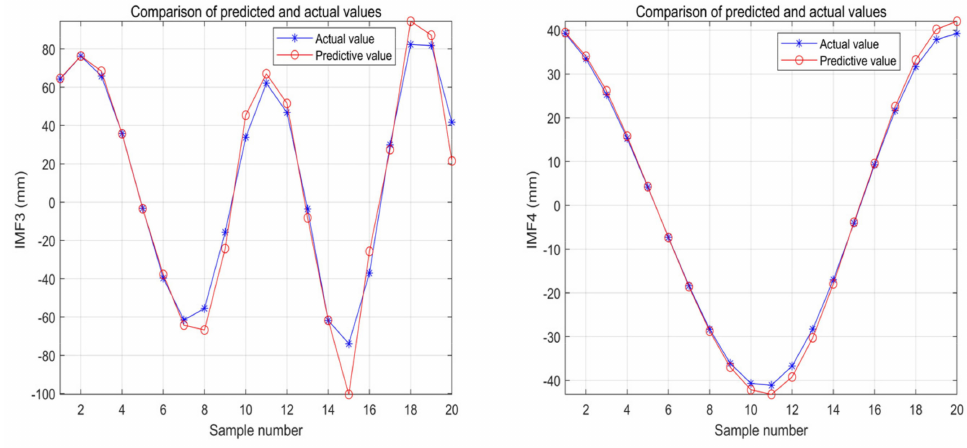
Figure 7. Comparison of IMF3 − IMF4 predicted true